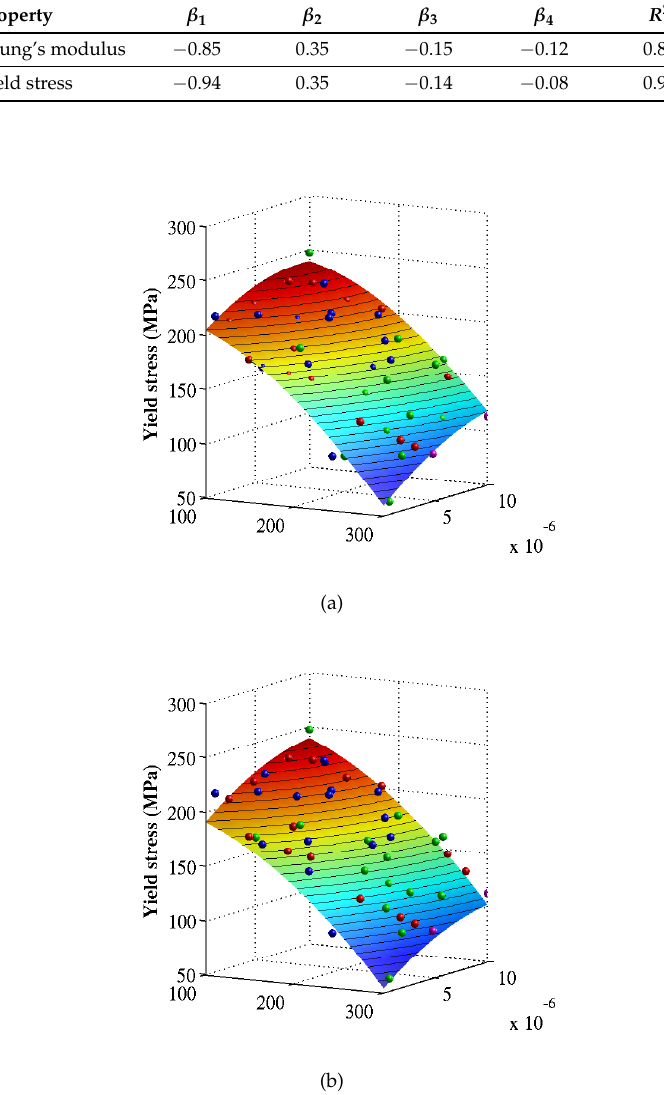
Figure 9. Surrogate models for the yield stress corresponding to ( a ) Kriging regression and ( b ) Bayesian updating. The training data are obtained from MD